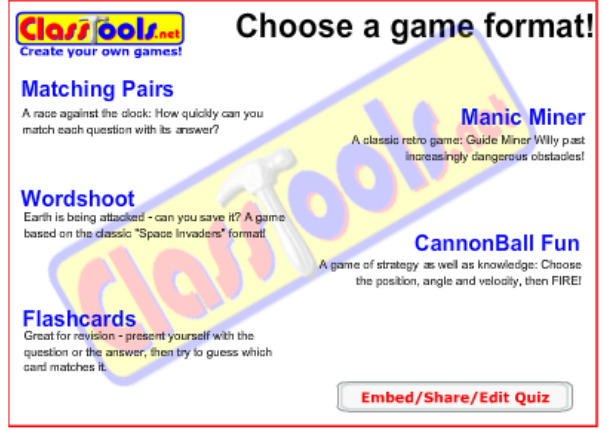
Figure 1. The five Arcade game formats available in the generator Figure 2. An example of our games to learn vocabulary